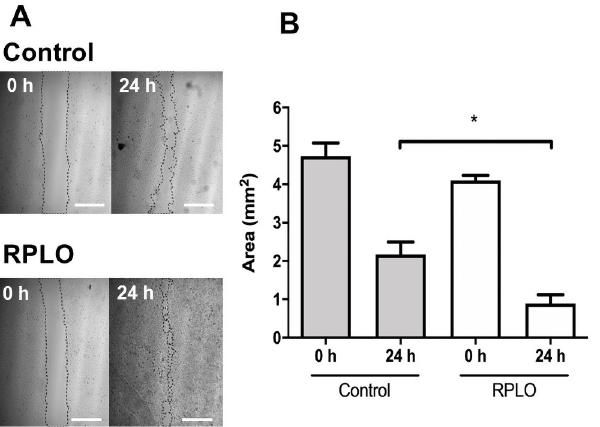
Fig 4. The effect of RPLO on the migration rate of MRC-5 cells. (A) Representative image from assay. The wound areas were determined at 0 h and after 24 h of incubation. Control cells were incubated with culture media. Cells incubated with 0.5% of oil were named RPLO. Scale bar is 1 mm. (B) The graph shows the means ± SEM of three independent experiments performed in triplicate (n = 9). An asterisk ( � ) indicate statistically significant differences between mean values (one-way ANOVA, Dunnett’s post-test, p < 0.05).